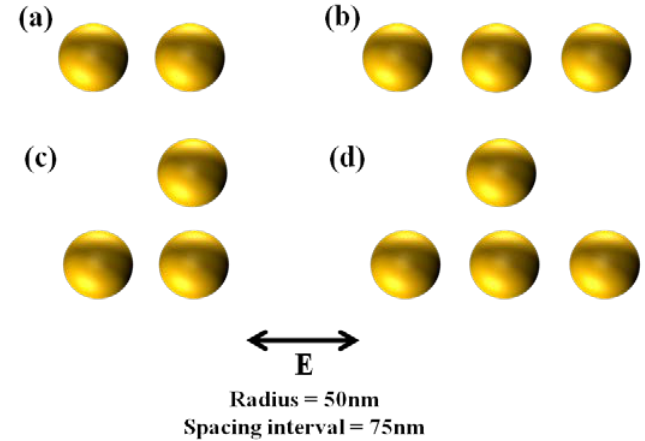
Figure 2. Array type of nanoparticles: (a) two nanoparticles; (b) three nanoparticles arrayed in a transverse direction; (c) three nanoparticles arrayed in the shape of a right triangle; (d) four nanoparticles arrayed in the shape of an isosceles triangle; (e) LSPR resonant spectra with respect to the number and position of nanoparticles. Incident electric field is 1